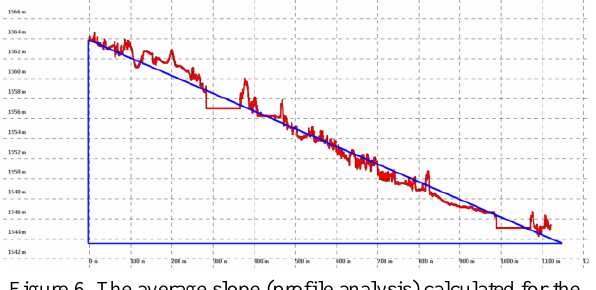
Figure 6. The average slope (profile analysis) calculated for the study area with QTM is 1.013° or 1.77 % slope (Applied Figure 7. Wetland areas delineated. Baseline and UAV wetland Imagery, 2015) delineation displayed on the 10 cm